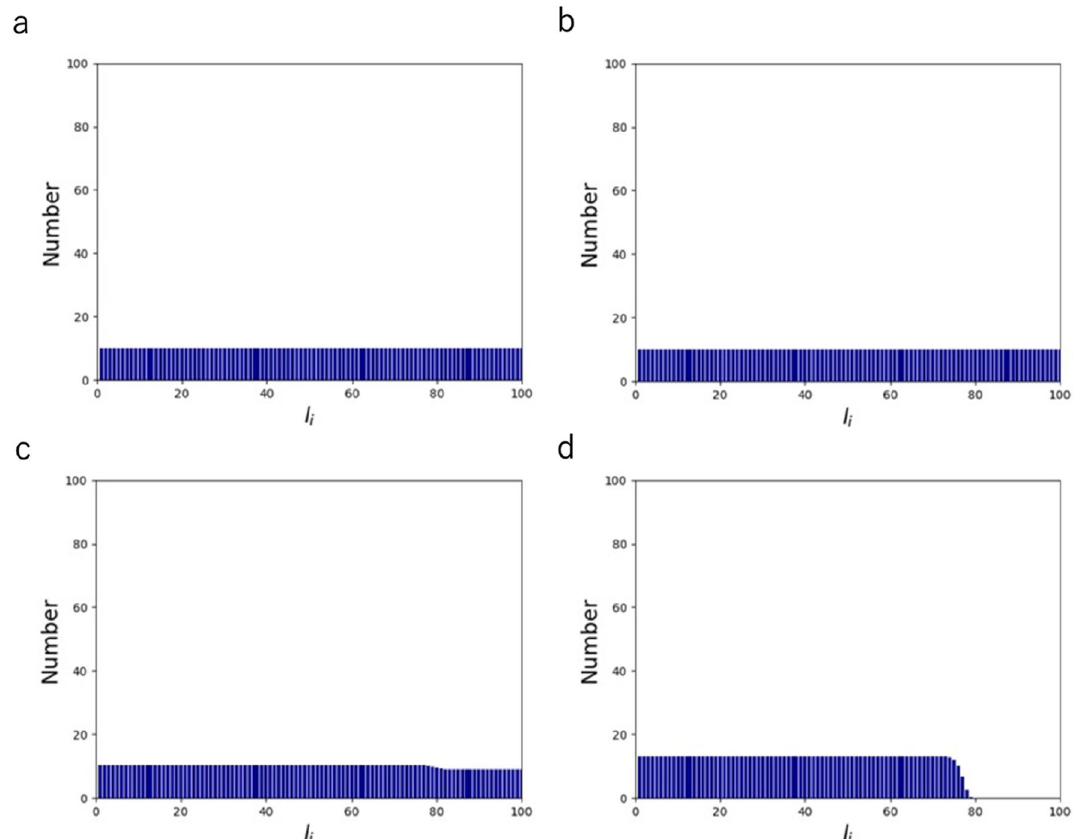
Figure 4. Length distribution of AFs comprising of N = 1000 monomers at f 0 = 10 –6 ( a ), f 0 = 10 –4 ( b ), f 0 = 10 –2 ( c ), and f 0 = 10 0 ( d